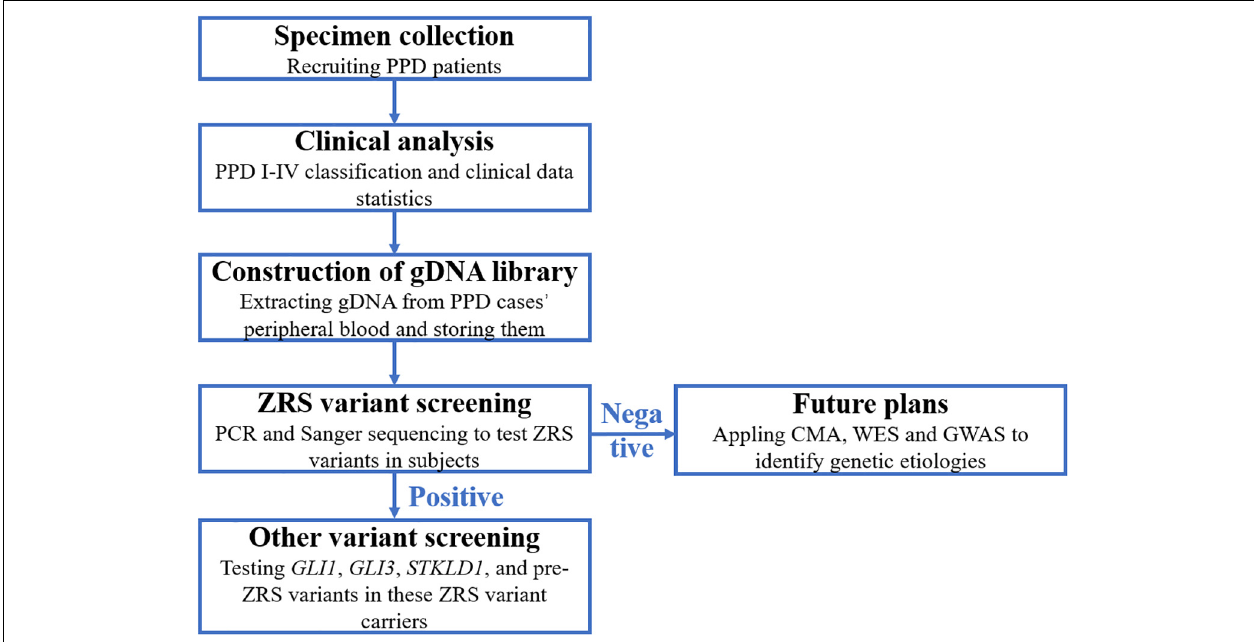
FIGURE 1 | The flow diagram of this study. PPD, preaxial polydactyly; CMA, chromosomal microarray analysis; WES, whole-exon sequencing; GWAS, genome-wide association